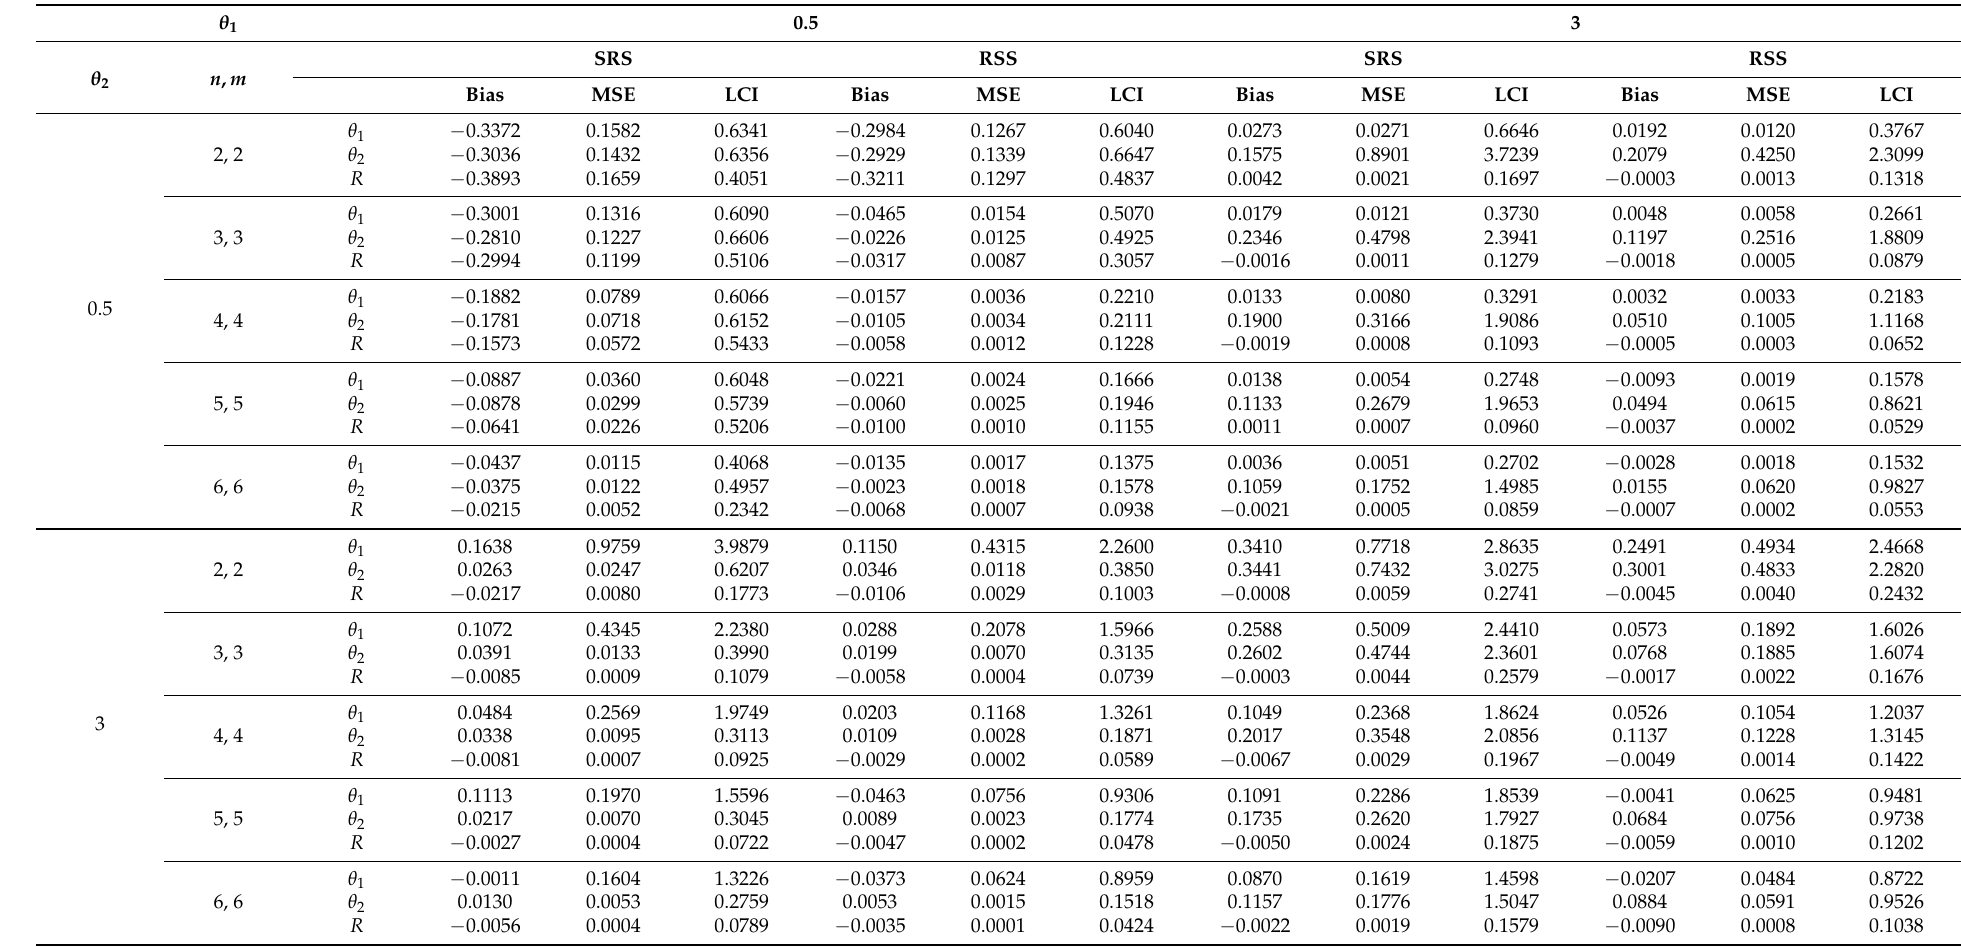
Table 3. SRS and RSS by Bayesian Method with NIP of Parameters and R of ITL Stress Strength